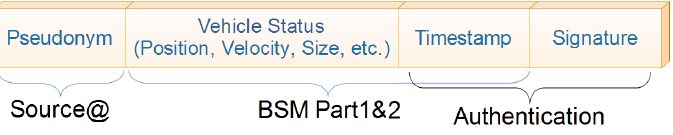
Figure 2. Basic Safety Message (BSM) beacon